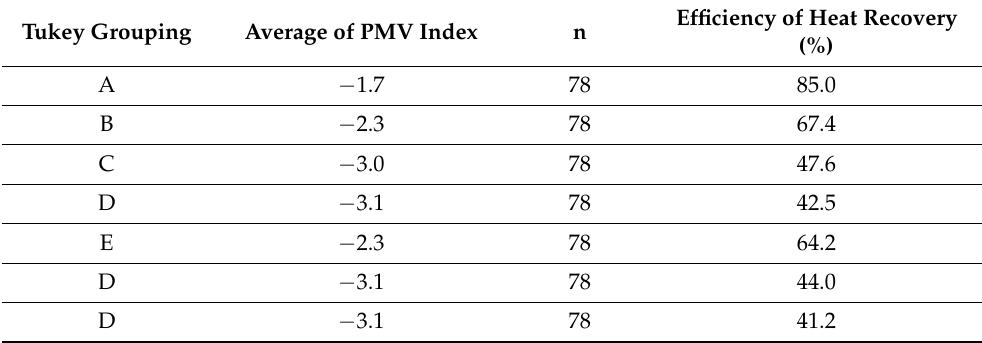
Table 5. The Tukey multiple comparison method tests for the PMV index characteristic in groups based on the efficiency of the heat recovery factor levels. Supply/exhaust cycle: 2